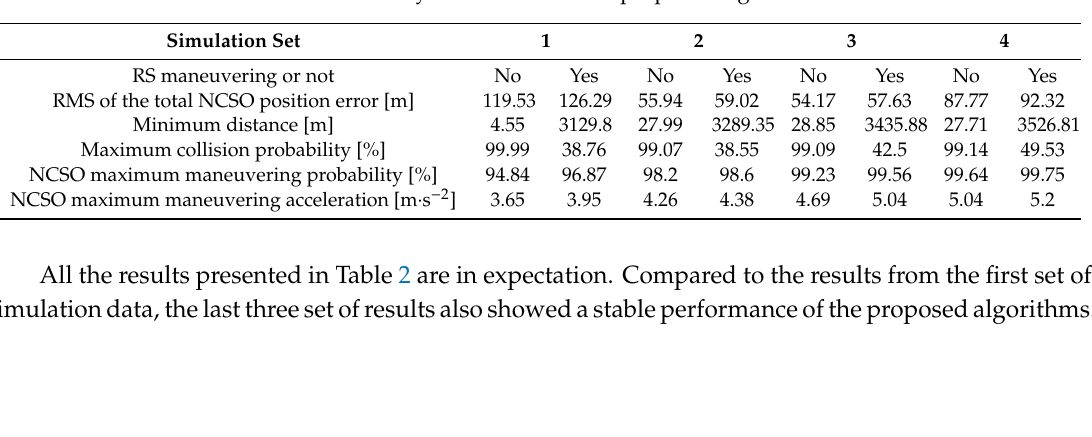
Figure 15. Minimum distances and collision probability between NCSO and RS, and maneuvering probability and maneuvering accelerations of NCSO for fourth simulation.